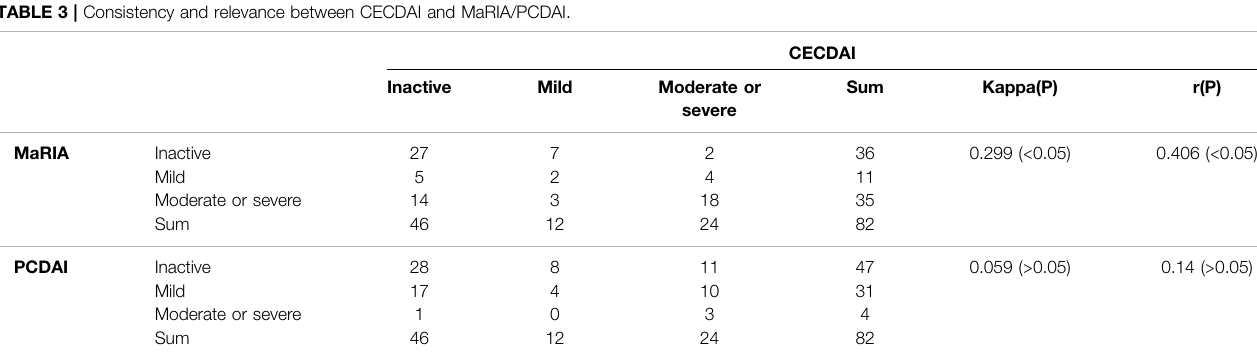
TABLE 3 | Consistency and relevance between CECDAI and